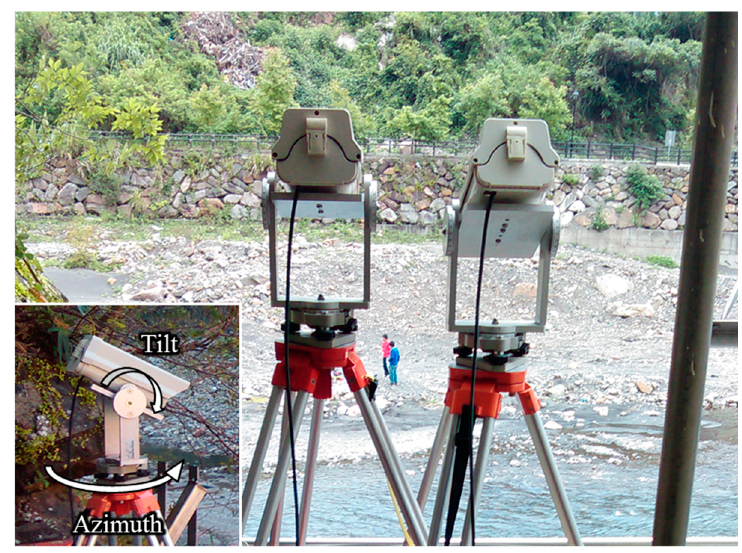
Figure 4. The automated discharge imaging system (ADIS) hardware system consists of two cameras, both enclosed in the weatherproof cases.